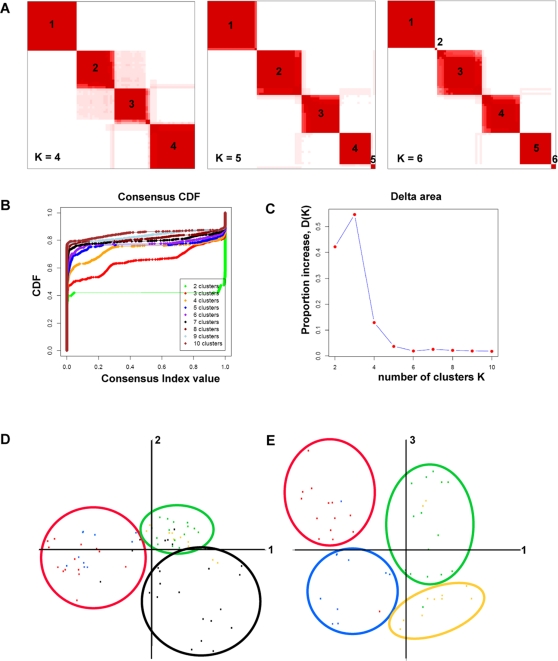
Robustness of sample classification.The robustness of the sample classifications was analyzed by consensus clustering, which uses multiple iterations of K-means clustering with random restart. 500 subsets of the data were sampled without replacement. The results of consensus clustering and Principal Component Analysis (PCA) applied to the 75 arrays and 995 intrinsic genes are shown. A. Consensus matrices are shown for K = 4, 5 and 6. Cluster numbers are shown and cluster assignments are summarized in Table 3. B. Empirical consensus distribution function (CDF) plots corresponding to K = 2,3,4…10. The ideal number of clusters can be identified when the area under the curve shows minimal increases with increasing K. C. Proportion increase Δ(K) in the area under the CDF. D. PCA was performed using TIGR MeV software; principal components 1 and 2 are plotted in 2-dimensional space. Samples (points in space) have been colored according Figure 2. Normal-like are green, limited orange, diffuse-proliferation in red and inflammatory in black. Circles indicate groups of samples distinguished by the top two principal components. E. Principal components 1 and 3 were plotted in two-dimensional space and show distinction between two groups within the diffuse-proliferation, normal-like and limited scleroderma.